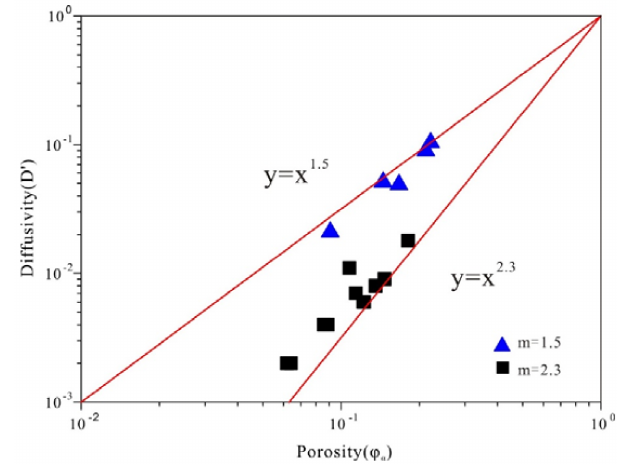
Figure 7. Diffusivity ( D (cid:48) ) vs. porosity ( ϕ a ) for coal samples (square point) and other rocks (triangle point data).